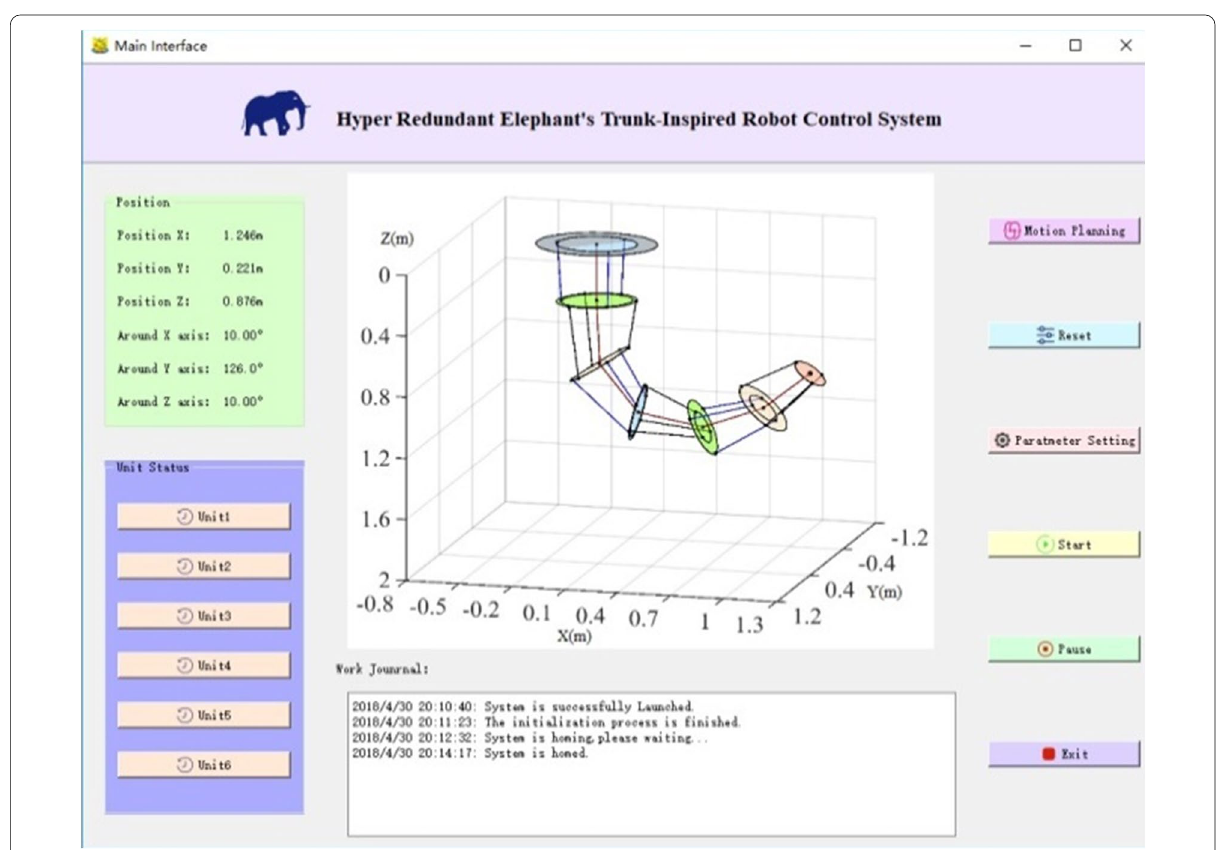
Figure 16 Main interface of PC control software for